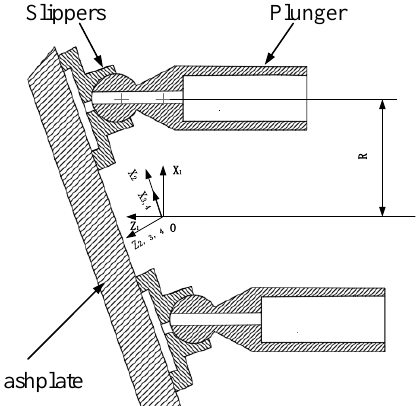
Figure 1. Relation coordinate diagram of the plunger swash plate.